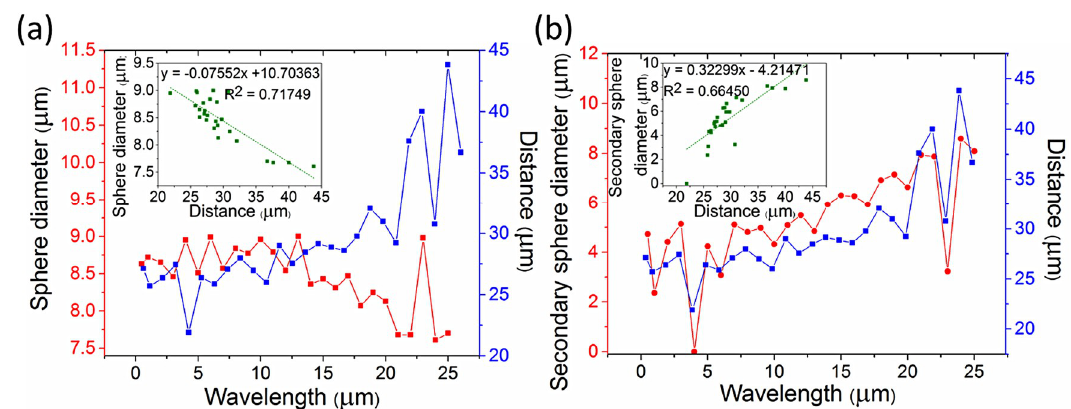
Figure 9. ( a ) Diameter of the primary spheres and distance between them as a function of the perturbation wavelength. ( b ) Diameter of the secondary sphere and distance between the primary spheres as a function of the perturbation wavelength.